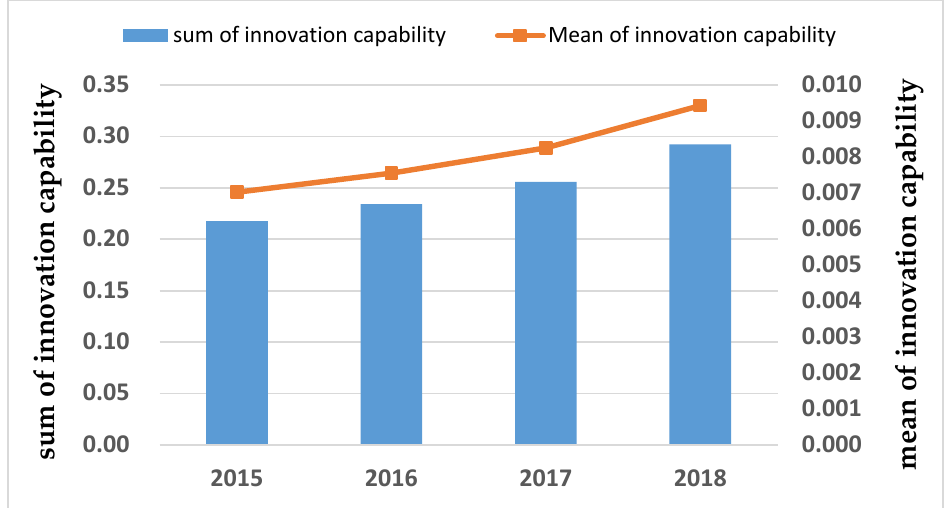
Figure 3. Evolution of the innovation capability in UAMRYR. Table 3. Innovation capability and ranking of cities in the UAMRYR from 2015 to 2018.